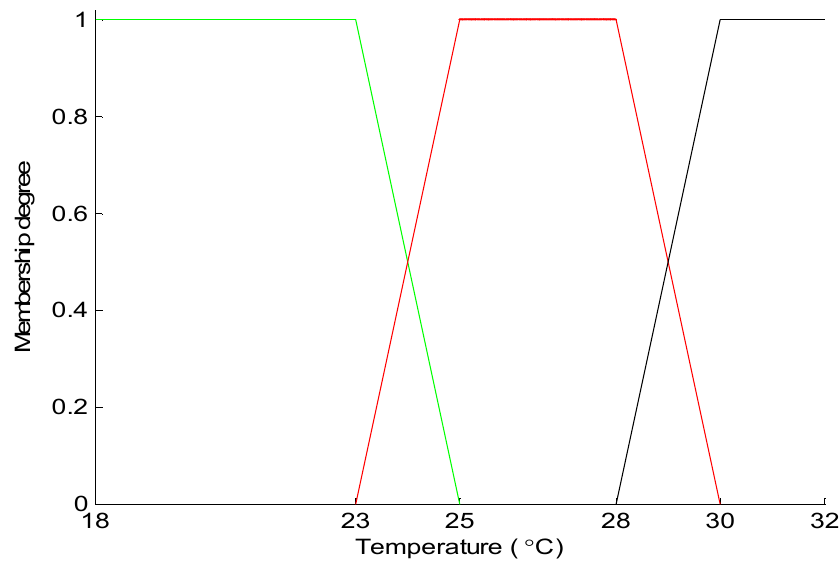
Figure 3. Relative humidity influence membership functions in